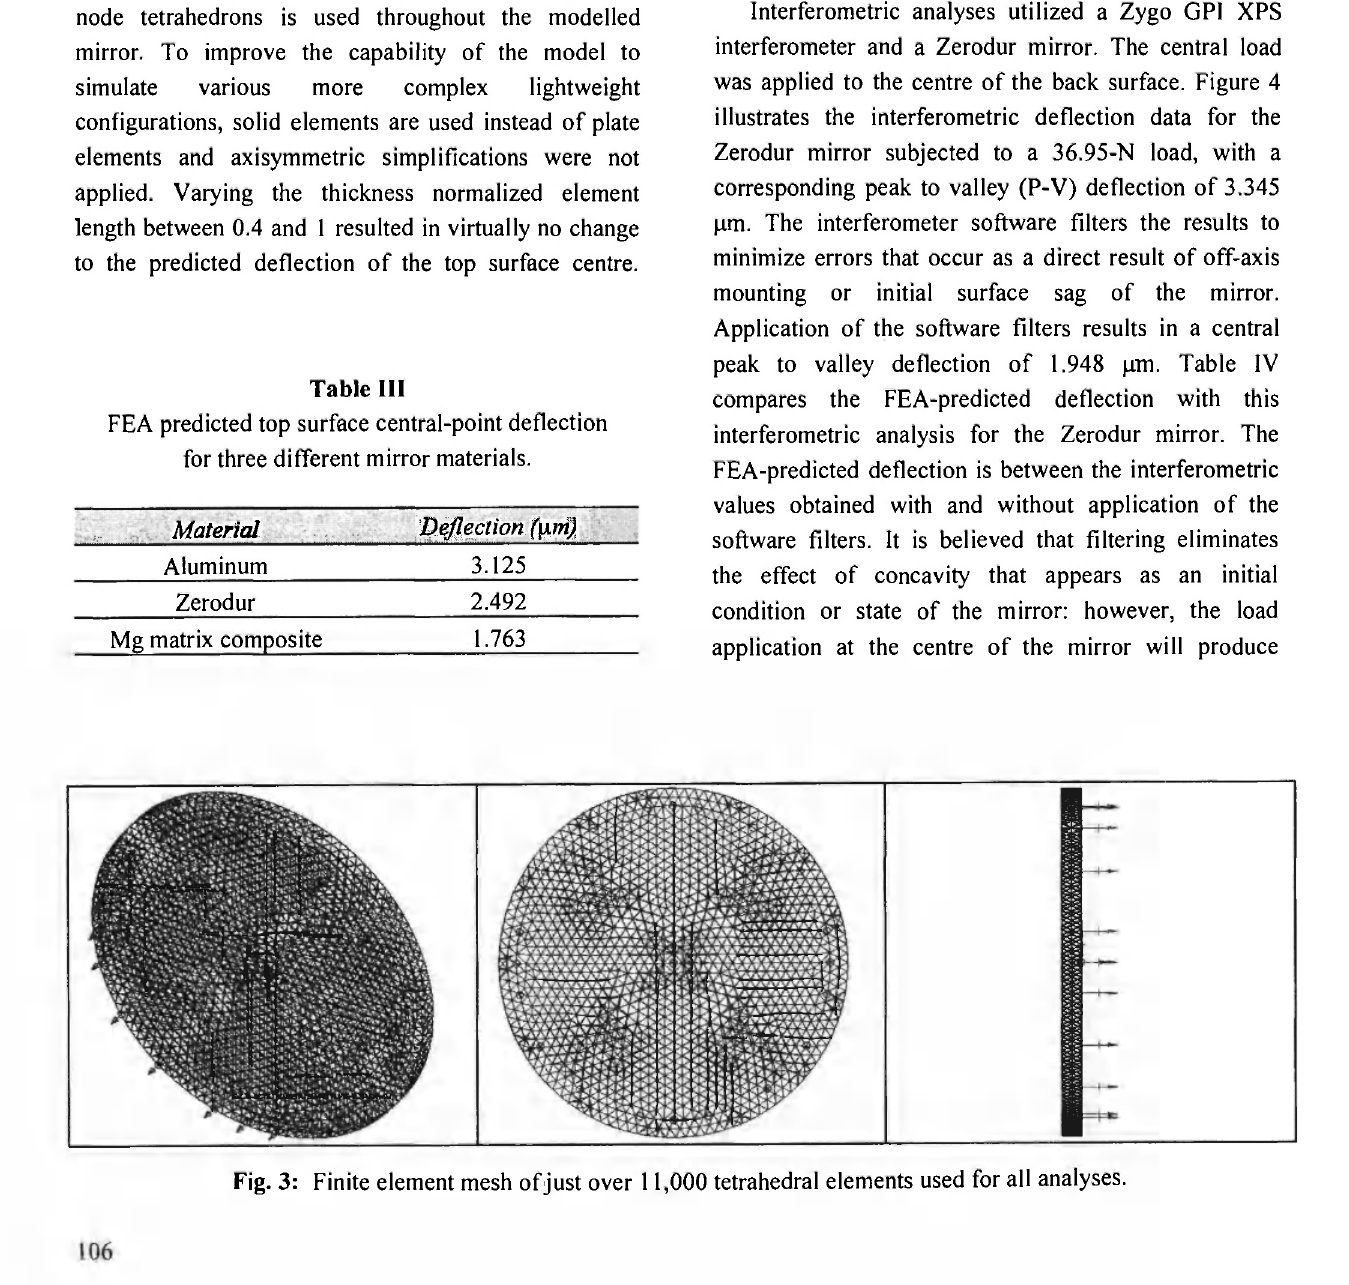
FEA predicted top surface central-point deflection for three different mirror materials.